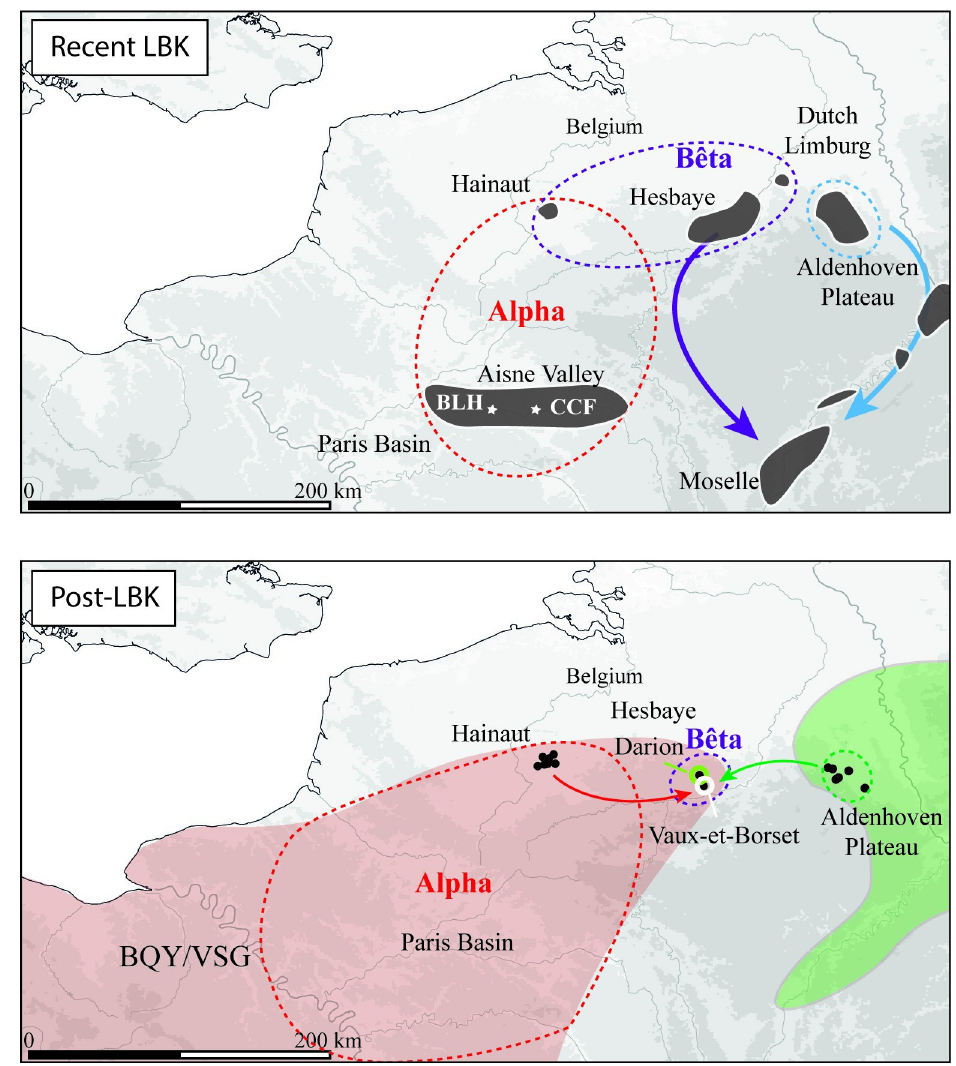
Fig 4. Map of the different traditions of blade debitage. The map shows the distribution of the main flint knapping traditions between the late LPC and post-LPC. During the first stage, strong links exist through the flint blade circulation networks Map base: Digital elevation model BD ALTI 1 from the IGN, 16 of february 2022. surface. The debitage is almost rotating. The striking platform is regularly maintained by removing centripetal flakes with centimetric dimensions, modifying the edge of the platform and creating negative bulb scars on the upper part of the flaking surface. This systematic proce- dure is associated with partial repairs of the platform and rare complete tablets when the multi- tude of flake detachments created a central dome-shaped convexity. The blade detachment is carefully prepared by abrasion of the overhang made with a stone tool. The detachment of small flakes creates closely-spaced concavities that result in frequent "morphologically dihe- dral" (false-dihedral) or plain concave butts. These butts result from repairs to the striking plat- form rather than from an intentional preparation of the impact zone. Knappers from A tradition seem to know the specific arrangements allowing the recurring production of blades with a regular trapezoidal cross-section.